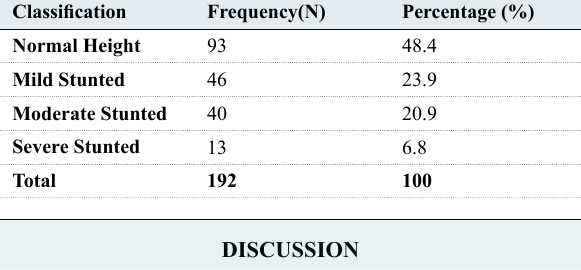
Table 3: Height for age according to Waterlow classification. (N=192) Classification Frequency(N) Percentage (%) Normal Height 93 48.4 Mild Stunted